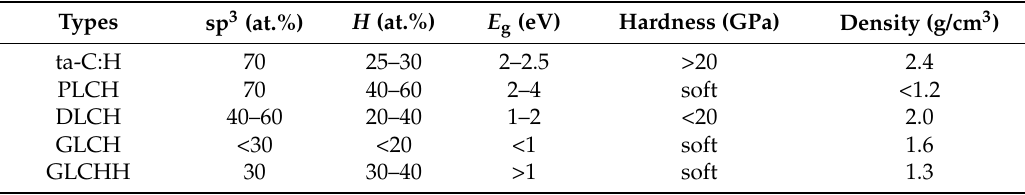
Table 1. Characteristics of ta-C:H and various a-C:H